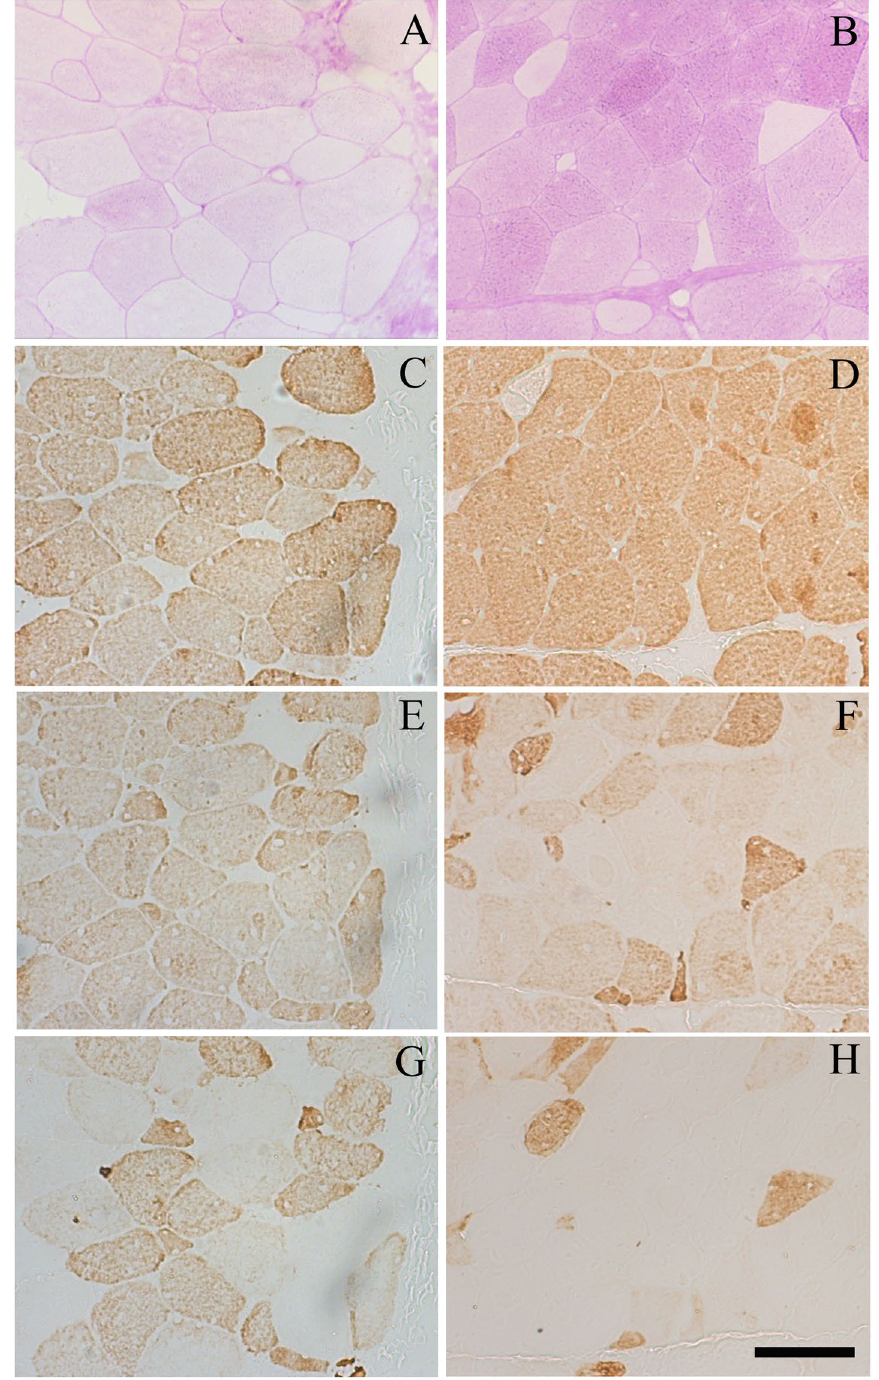
Figure 1. Serial light micrographs of the pHu + ( A , C , E , G ) and pHu − ( B , D , F , H ) pectoralis major muscles. Periodic Acid Schiff histochemical staining ( A , B ), immunohistochemical staining of the adult ( C , D ), both embryonic and neonatal ( E , F ), and neonatal ( G , H ) isoforms of the fast myosin heavy chain. The adult and neonatal isoforms of the chicken fast myosin heavy chain were detected using the MF14 ( C , D ) and 2E9 ( G , H ) antibodies, respectively; the embryonic and neonatal isoforms were simultaneously revealed using the B103 antibody ( E , F ). All primary antibodies were purchased from the Developmental Studies Hybridoma Bank (Iowa City, IA). Scale bar: 100 µ